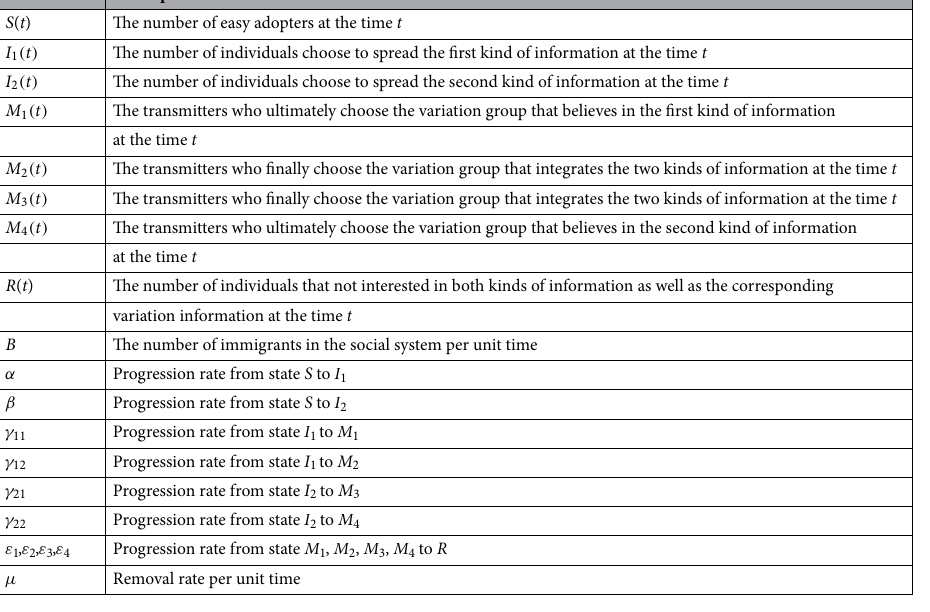
Table 1. The parameters description of S 2 I 4 MR